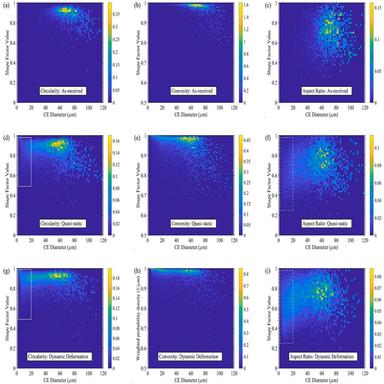
Correlated volume-weighted probability density for the coarse powder (220F): (a), (b) and (c) are correlations between circularity, convexity, aspect ratio and particle size in the as- received state respectively; (d), (e) and (f) are the same correlated distributions for the quasi-static deformation; (g), (h) and (i) are for the dynamic deformation from Kolsky bar tests.